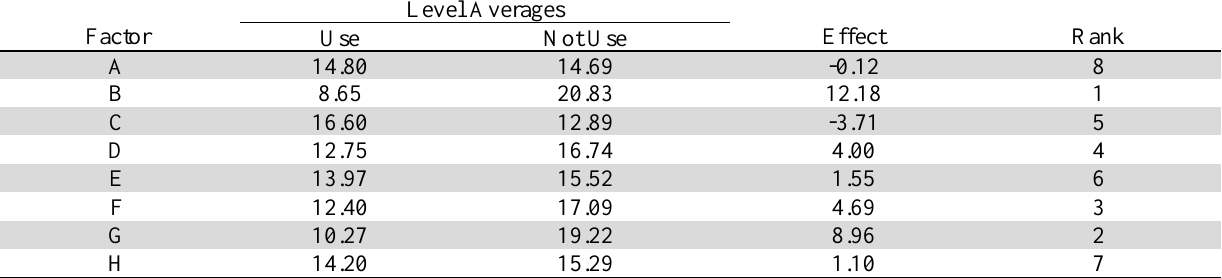
Level averages and factor